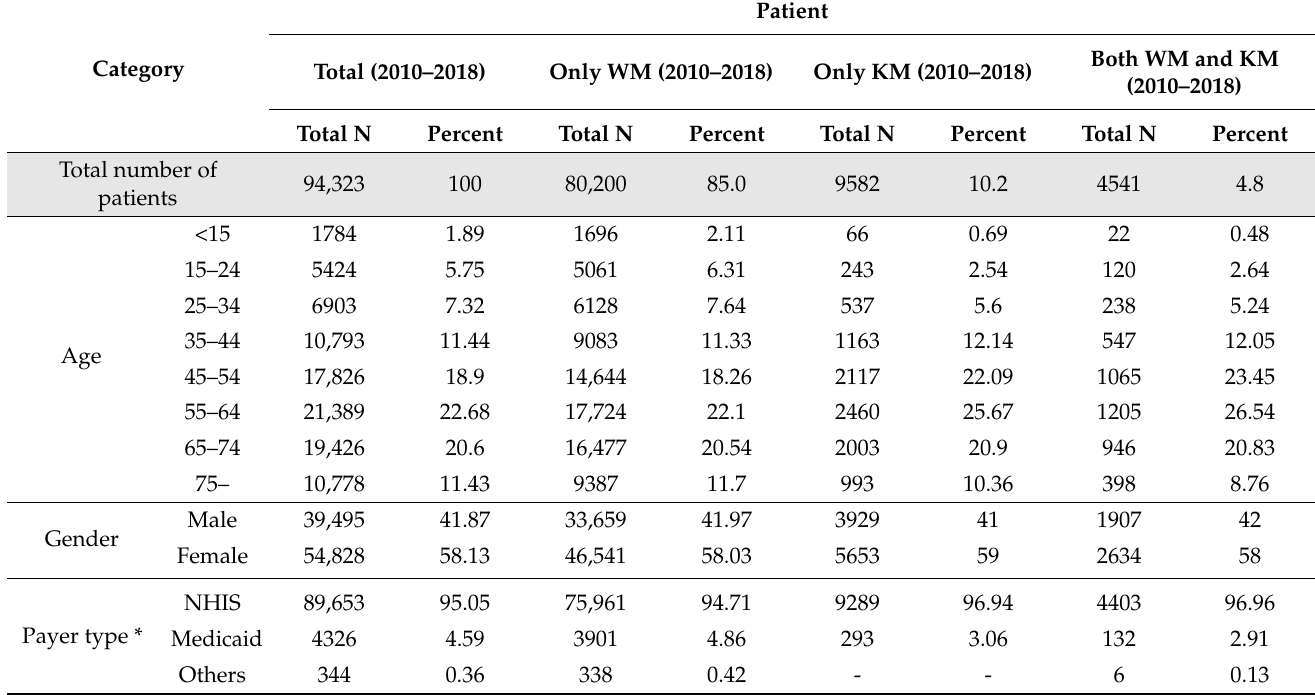
Table 2. Patients’ basic